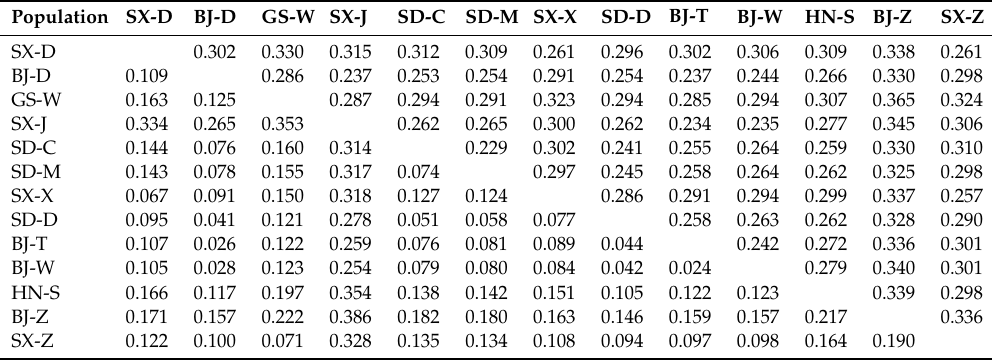
Table 2. Estimates of evolutionary divergence (Ds) (down) and genetic di ff erentiation (Fst) (up) over sequence pairs and between